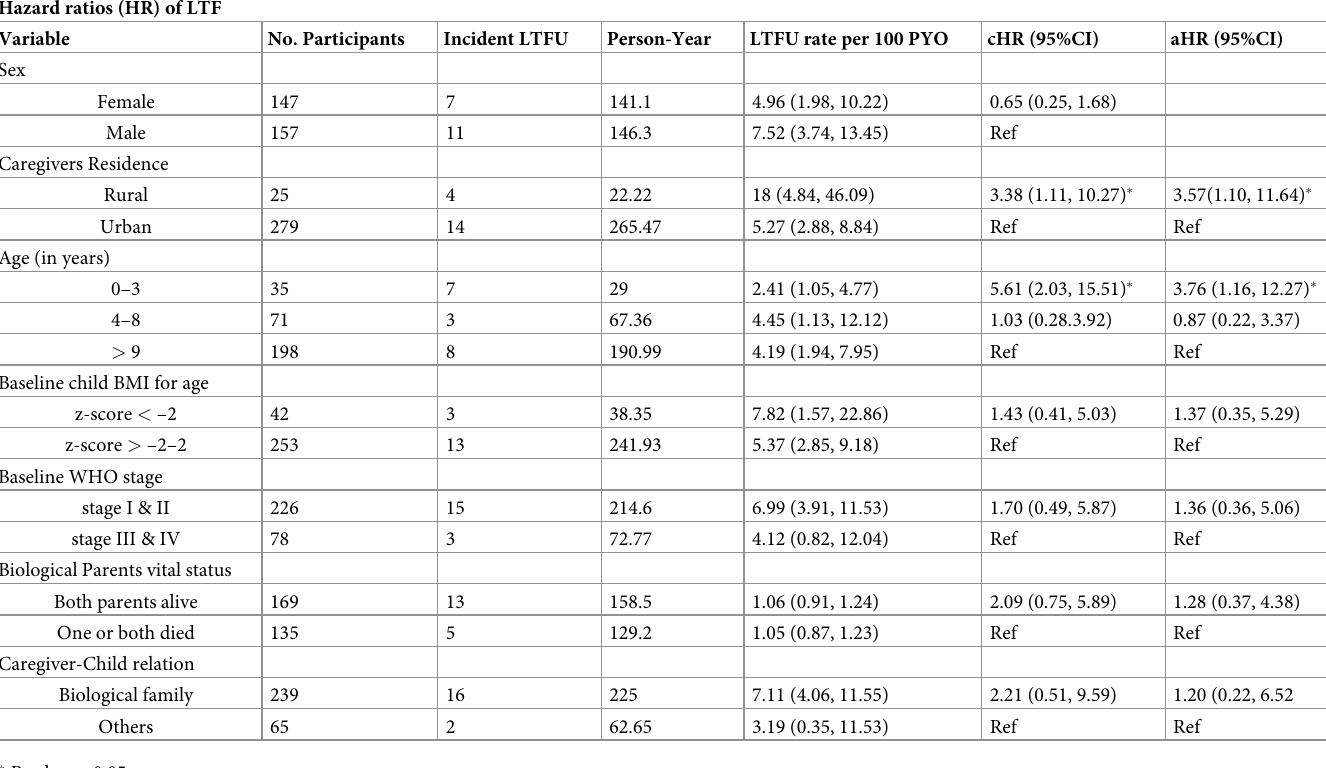
Table 3. Hazard ratios (HR) of LTFU according to Cox regression analyses, Ethiopia, 2017. Hazard ratios (HR) of LTF